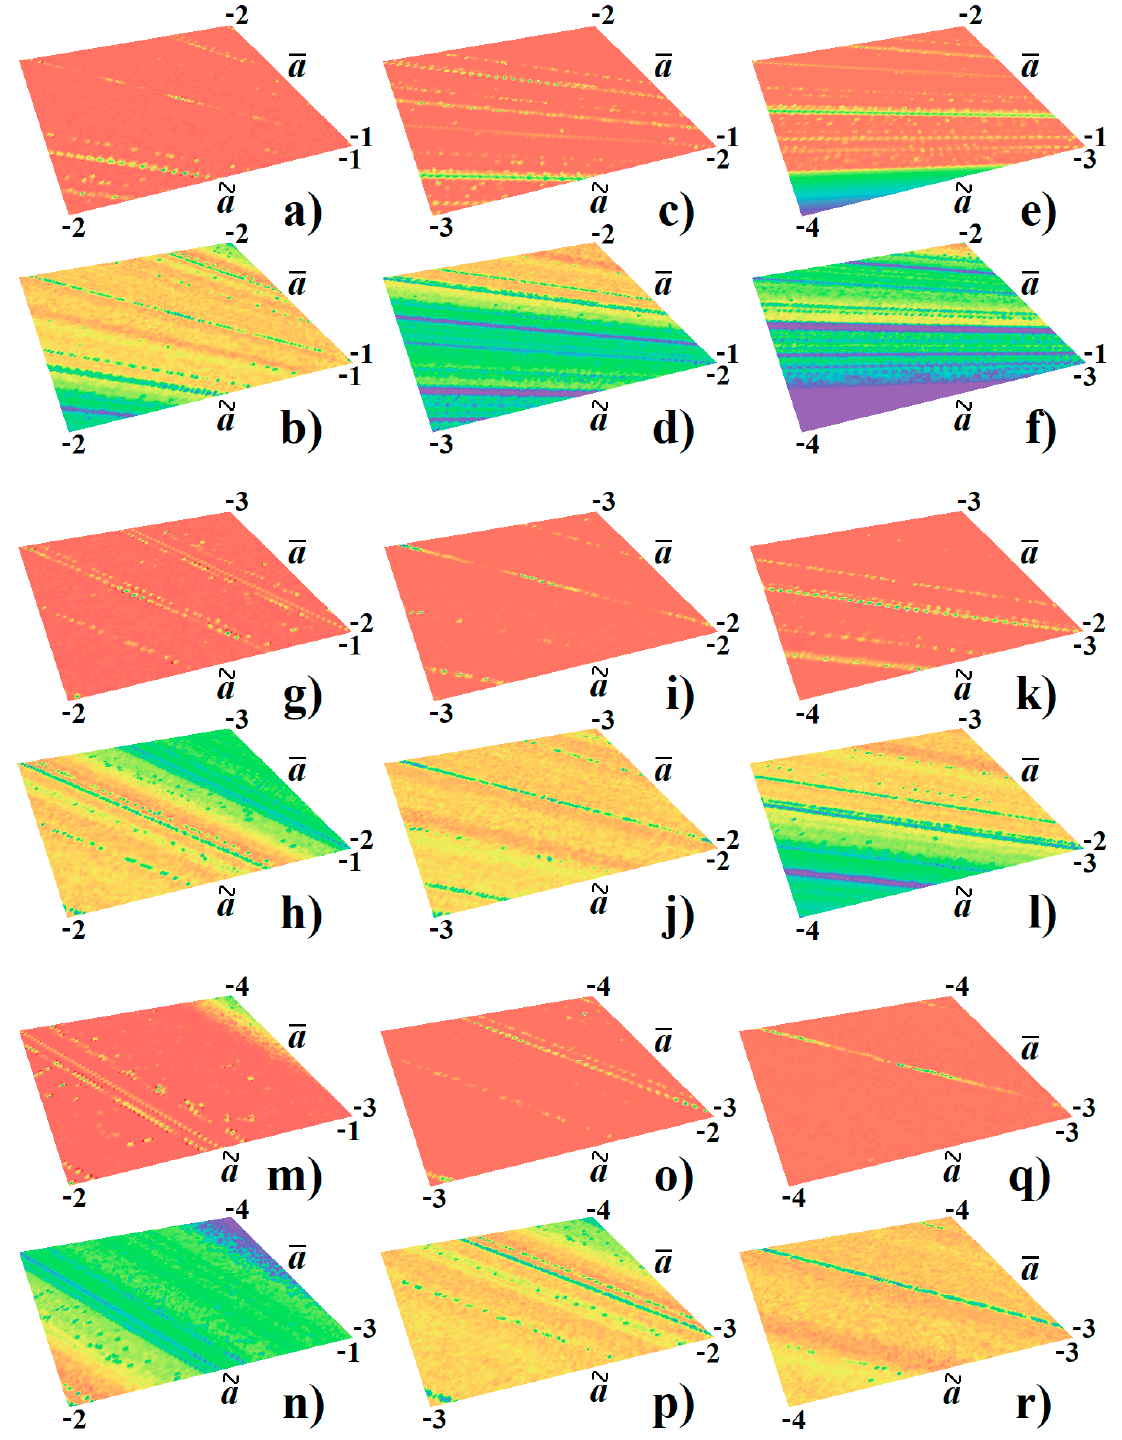
Figure 6. Rainbow-scaled contour plots of LLE as two-dimensional functions of parameters of generalized transistors for fourth order dynamical system: ( a ) second LE and ( b ) first LE for parameter range (cid:101) a ∈ ( − 2, − 1 ) , a ∈ ( − 2, − 1 ) , ( c ) second LE and ( d ) first LE for parameter range (cid:101) a ∈ ( − 3, − 2 ) , a ∈ ( − 2, − 1 ) , ( e ) second LE and ( f ) first LE for parameter range (cid:101) a ∈ ( − 4, − 3 ) , a ∈ ( − 2, − 1 ) , ( g ) second LE and ( h ) first LE for parameter range (cid:101) a ∈ ( − 2, − 1 ) , a ∈ ( − 3, − 2 ) , ( i ) second LE and ( j ) first LE for parameter range (cid:101) a ∈ ( − 3, − 2 ) , a ∈ ( − 3, − 2 ) , ( k ) second LE and ( l ) first LE for parameter range (cid:101) a ∈ ( − 4, − 3 ) , a ∈ ( − 3, − 2 ) , ( m ) second LE and ( n ) first LE for parameter range (cid:101) a ∈ ( − 2, − 1 ) , a ∈ ( − 4, − 3 ) , ( o ) second LE and ( p ) first LE for parameter range (cid:101) a ∈ ( − 3, − 2 ) , a ∈ ( − 4, − 3 ) , ( q ) second LE and ( r ) first LE for parameter range (cid:101) a ∈ ( − 4, − 3 ) , a ∈ ( − 4, − 3 ) . Individual images are plotted for different shapes of forward polynomial trans-conductances.